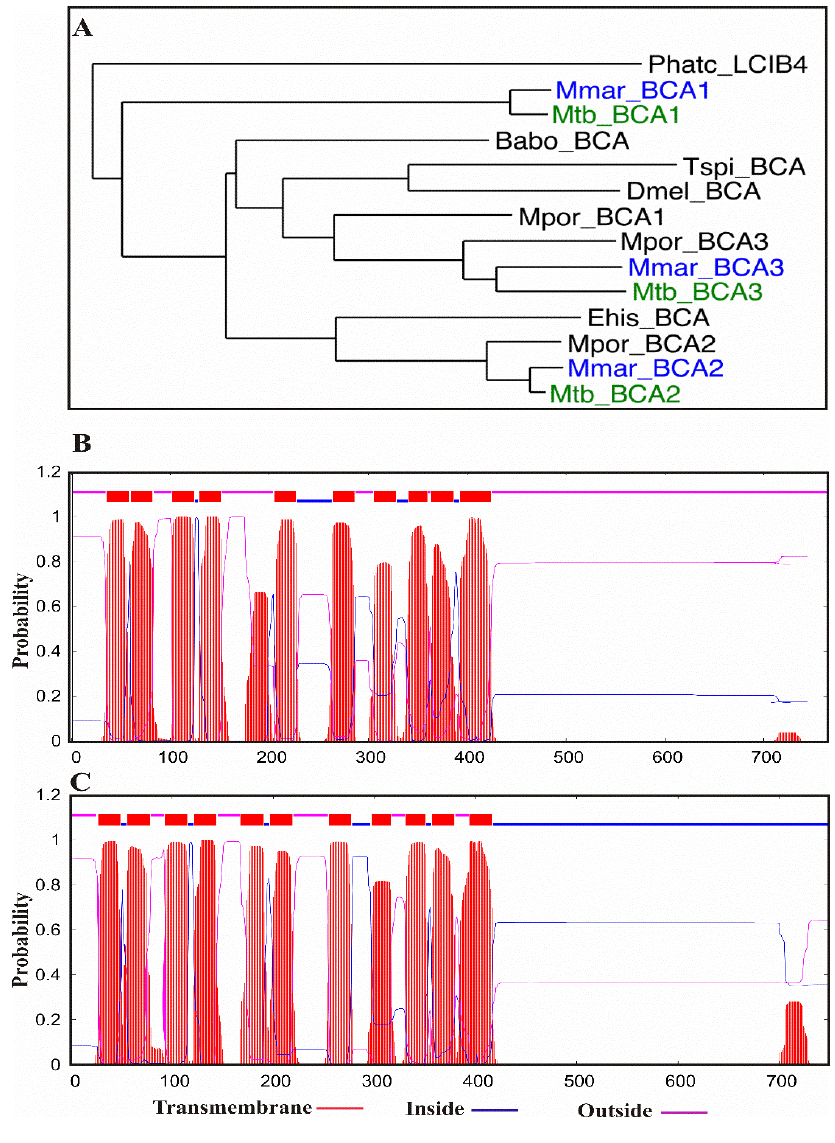
Figure 5. Phylogeny of mycobacterial β -CA sequences and transmembrane domain prediction of Mtb and Mmar β -CA3 protein sequences. The phylogenetic tree in panel ( A ) shows the evolutionary relationship of the Mtb and Mmar β -CA protein sequences in comparison with β -CAs from other organisms (Phatc = Phaeodactylum tricornutum ; Babo = Brucella abortus ; Tspi = Trichinella spiralis ; Dmel = Drosophila melanogaster ; Mpor = Mycolicibacterium porcinum ; and Ehis = Entamoeba histolytica ). Panel ( B ) shows the predicted transmembrane plot of Mtb β -CA3, and panel ( C ) shows the predicted transmembrane plot of Mmar β -CA3